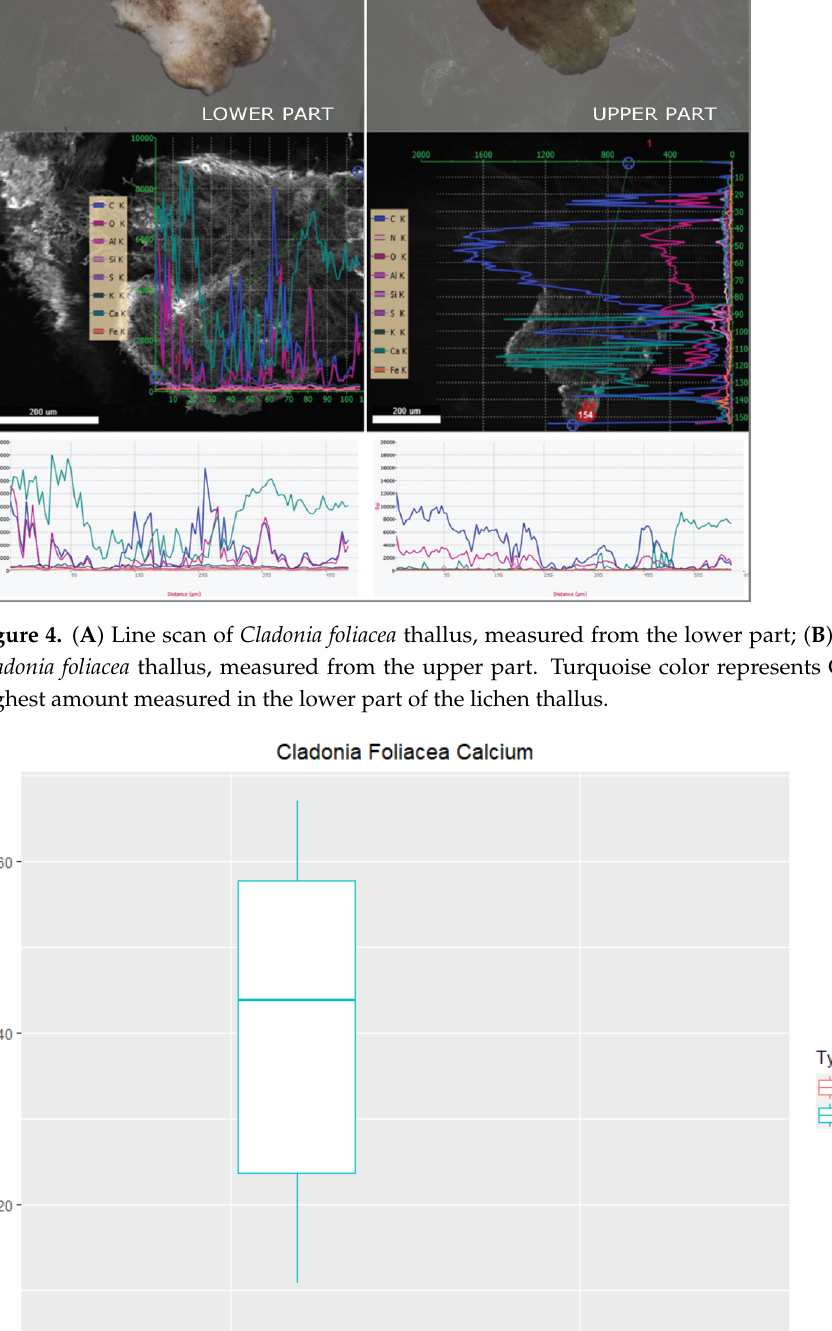
Figure 6. XRD pattern of the Ca-containing C. furcata ( black pattern ) and C. foliacea ( red pattern ) and corresponding intensities of the identified CaOX species according to JCPDS-PDF2 database (black line—35-0914, red lines—04-0702). The corresponding phases and formulas are provided in the figure. Thus, both CaOX hydrate minerals, weddellite (CaC 2 O 4 ∙ 2H 2 O) in C. foliacea (Figure 7) and whewellite (CaC 2 O 4 ∙ H 2 O) in C. furcata (Figure 8), were identified in the lichens by Raman spectroscopy. The Raman spectra of the CO stretching in the region 1250–1800